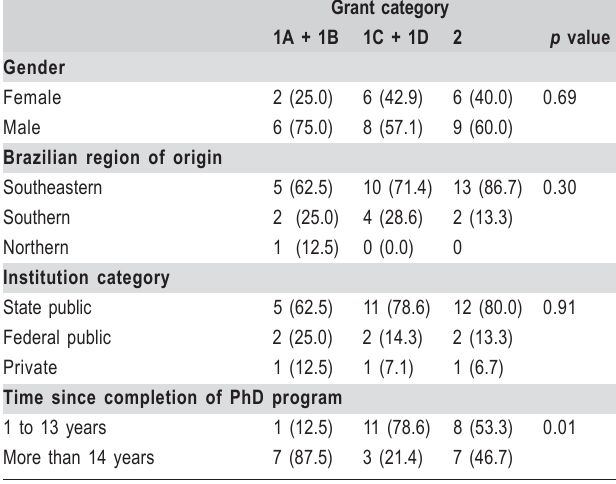
Table 2. Bivariate analysis between grant categories